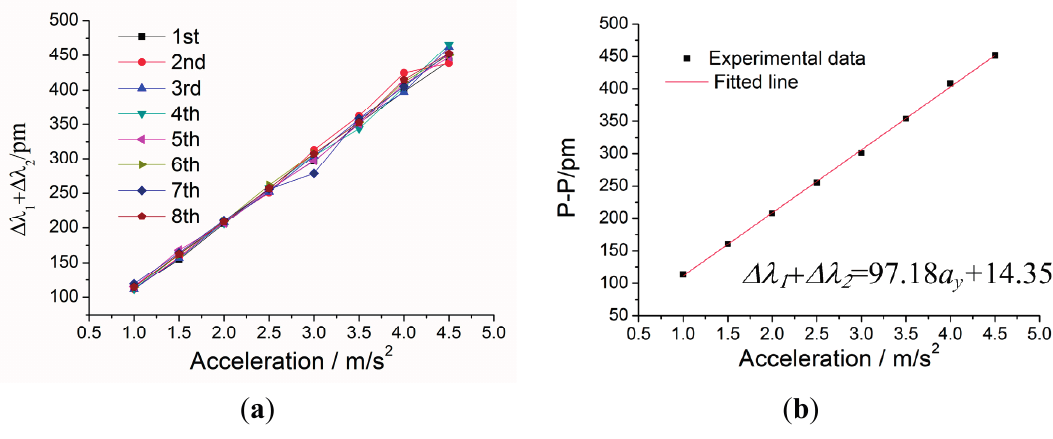
Figure 16. Addition value Δ λ 1 + Δ λ 2 versus acceleration a y under y -direction excitation with the acceleration frequency of 8 Hz. ( a ) Relation between Δ λ 1 + Δ λ 2 and acceleration a y within 1–4.5 m/s 2 . ( b ) The linear fitting curve.